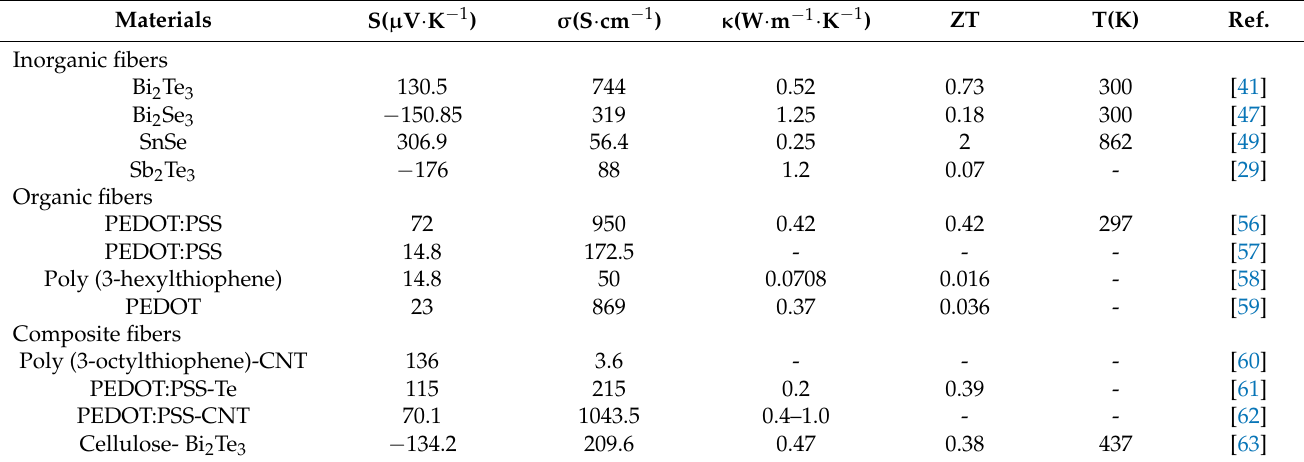
Table 1. Summary of some popular thermoelectric fiber materials and their